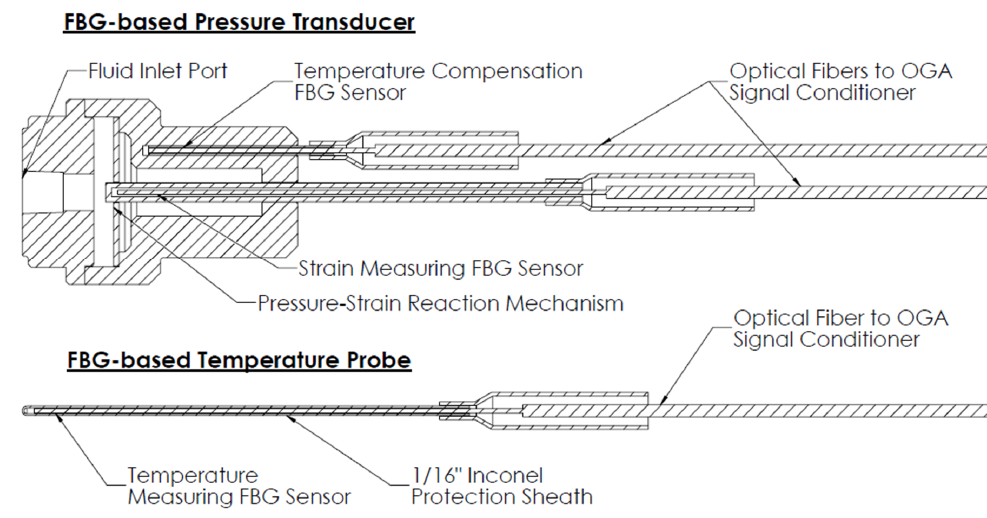
Figure 3. Diagram of custom FBG-based temperature probe and pressure transducer developed for isotope production experiments.